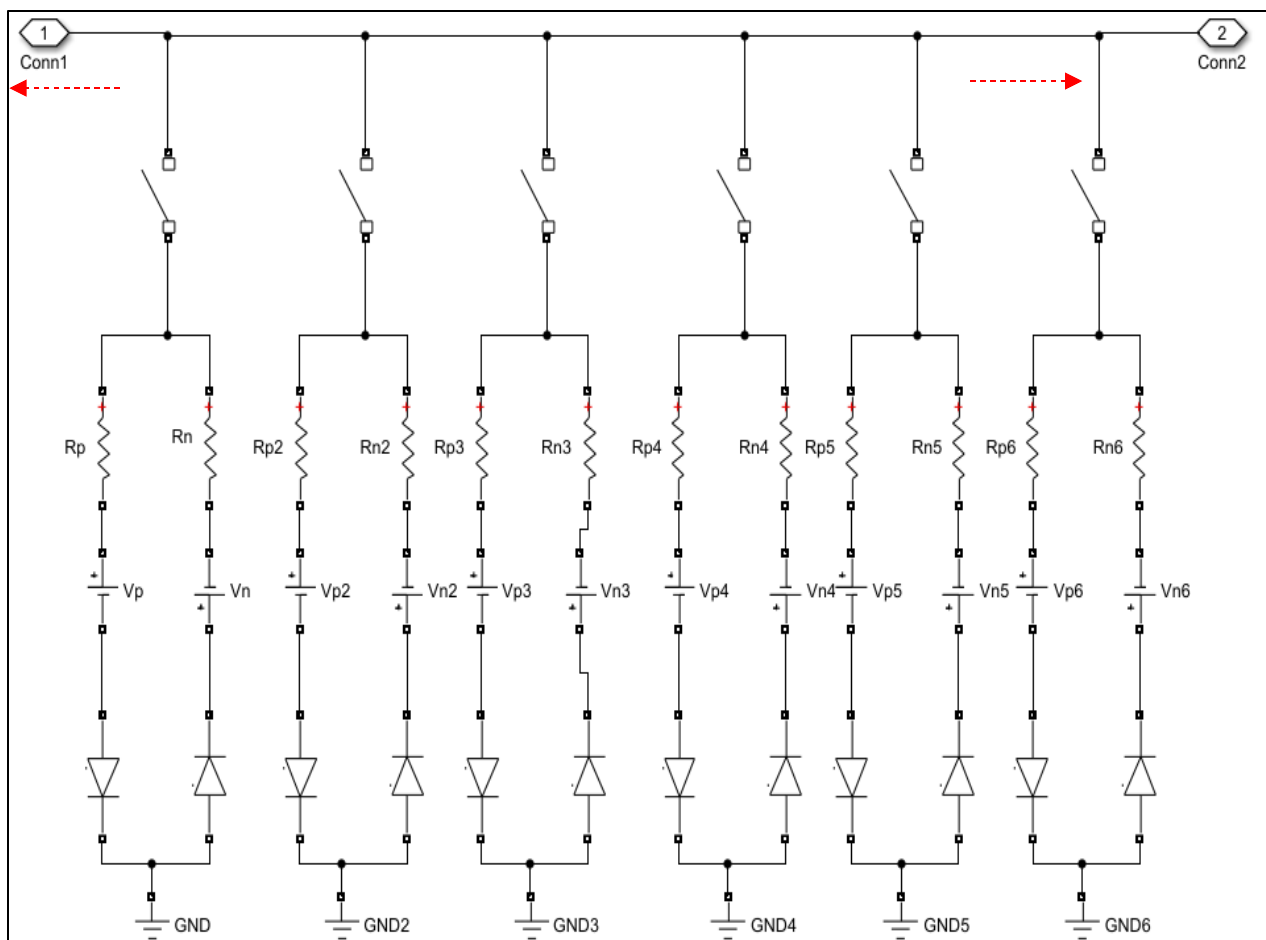
Figure 2. HIF model based on Emanuel arc model.